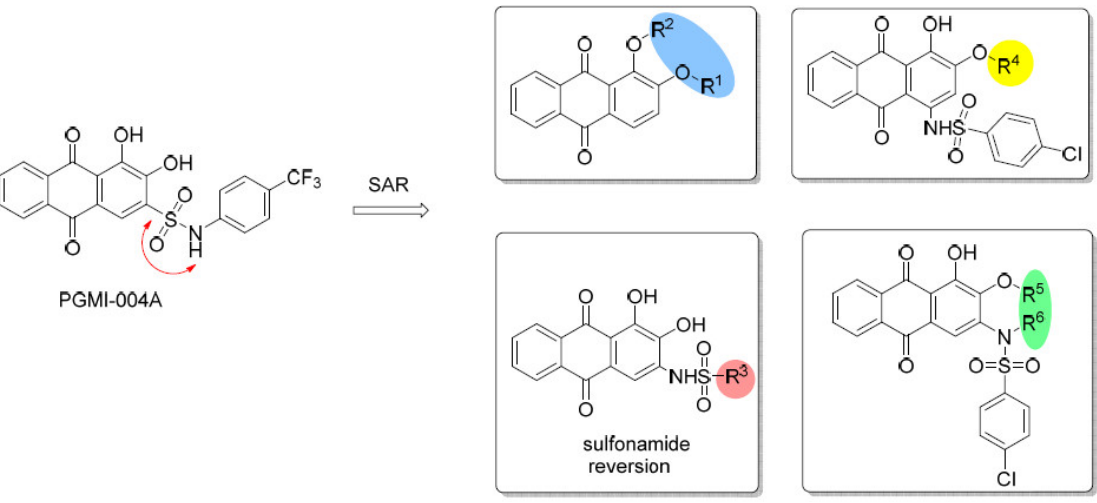
Figure 2. The optimization strategy and SAR exploration of the anthraquinone derivatives against PGAM1.